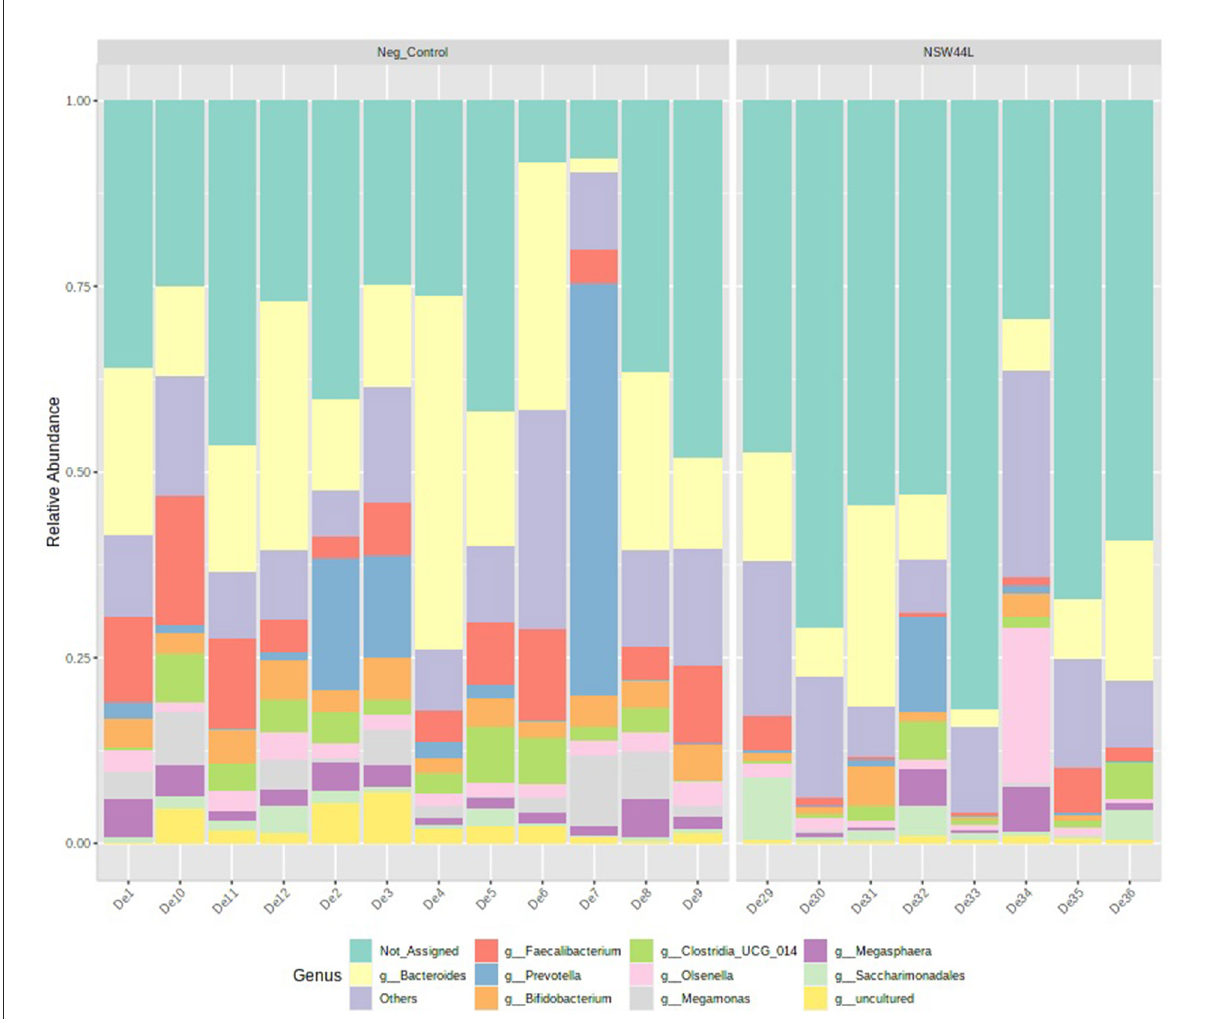
FIGURE3 Relative abundance of top 10 genera detected in caecal content of unchallenged and C. hepaticus NSW44L challenged